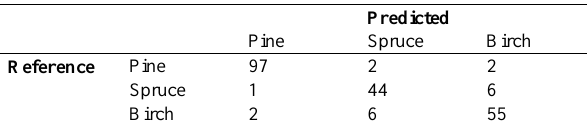
Table 3. Confusion matrix of classification based on intensity features of first returns with 15 best features. Total accuracy is 91.2%.